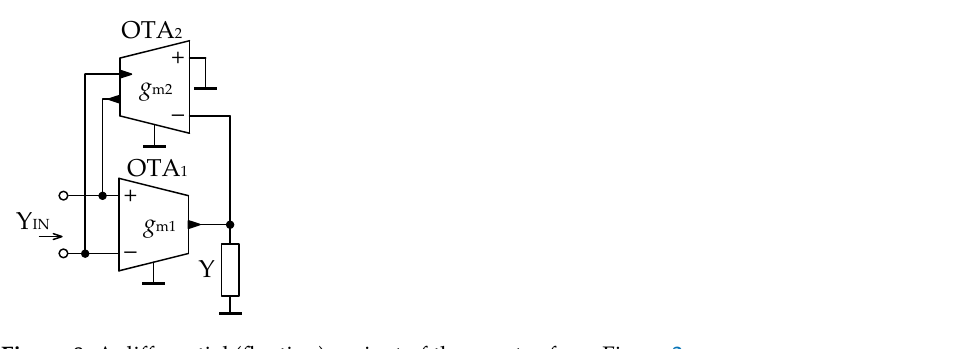
Figure 7. Flowchart of the setting of gyrator parameters.